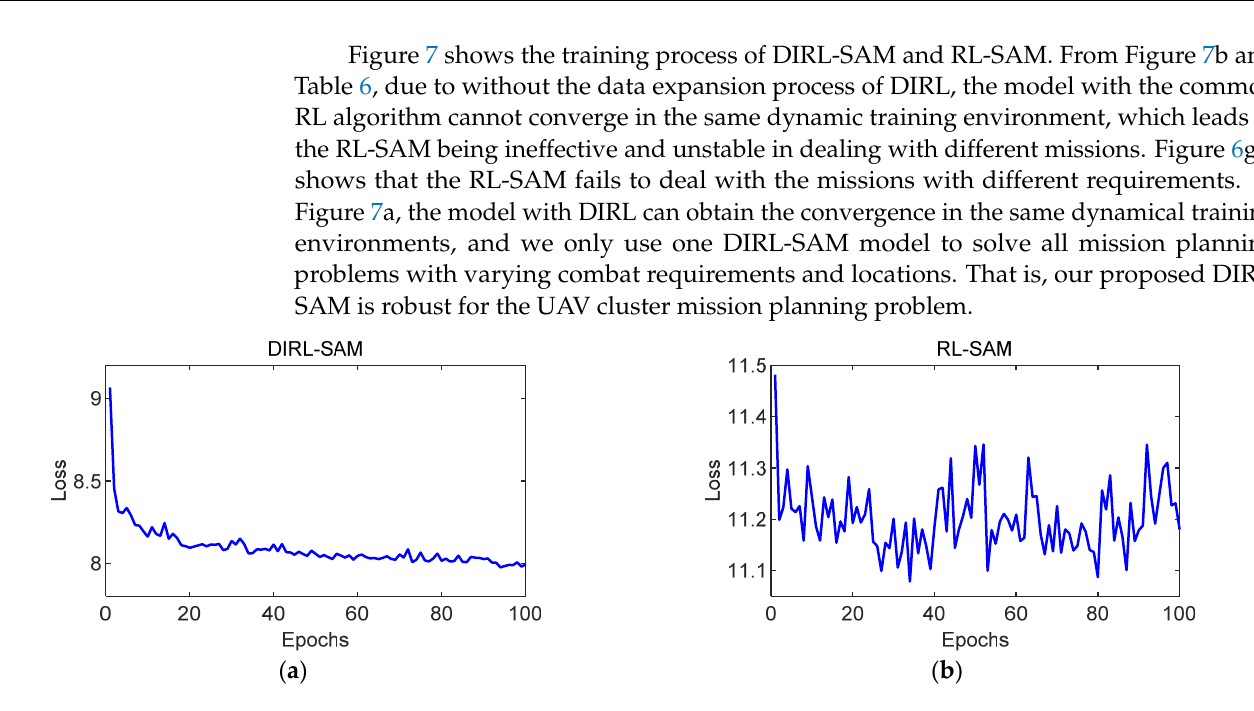
Figure 7. The training process of DIRL-SAM and RL-SAM: ( a ) training process of DIRL-SAM; ( b ) training process of RL-SAM.